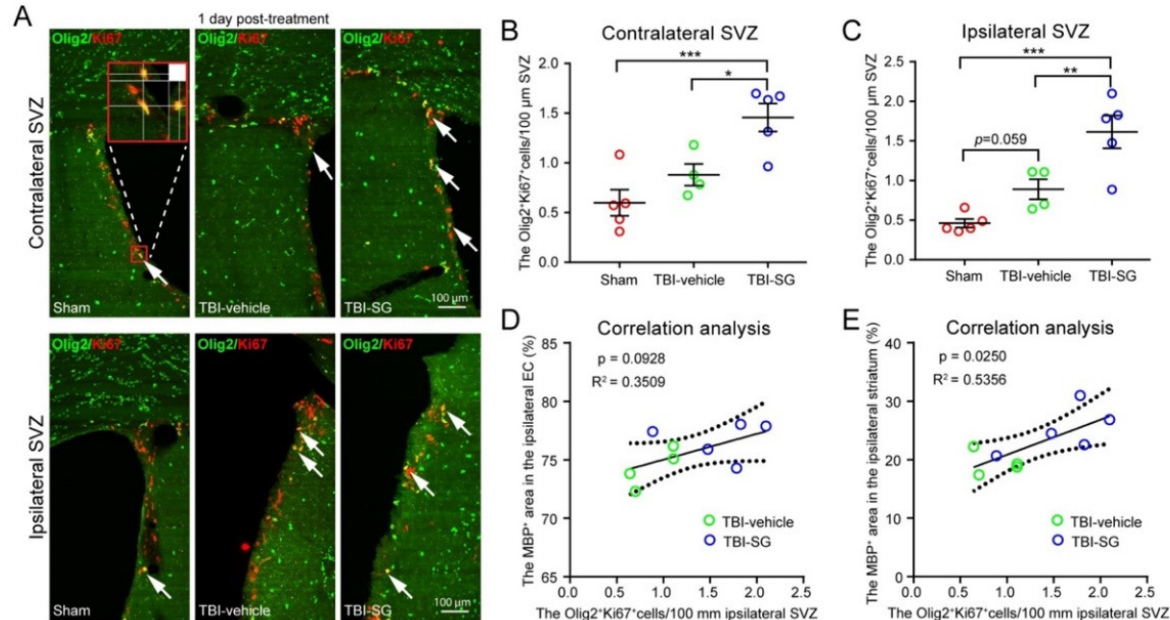
Figure 6. SCF + G-CSF treatment promotes the proliferation of oligodendrocyte progenitor cells (OPCs) in the subventricular zone (SVZ) in the chronic phase of severe TBI. ( A ) Representative images of proliferating OPCs (the arrow-indicated yellow cells co-expressing Olig2 and Ki67) in the contralateral and ipsilateral SVZ at 1day post-treatment. ( B , C ) Quantitative data of analysis of the number of Olig2 + Ki67 + double positive OPCs in the contralateral SVZ ( B ) and Ipsilateral SVZ ( C ) at 1 day post-treatment. One-way ANOVA followed by Fisher’s LSD test. * p < 0.05, ** p < 0.01, *** p < 0.001. Scale bars: 100 µ m. SG: SCF + G-CSF. ( D ) Correlation between MBP + area in the ipsilat- eral external capsule (EC) and the number of Olig2 + Ki67 + double positive OPCs in the ipsilateral SVZ. ( E ) Correlation between MBP + area in the ipsilateral striatum and the number of Olig2 + Ki67 + double positive OPCs in the ipsilateral SVZ. Pearson’s correlation coefficient test (linear regression) was used for correlation analysis.